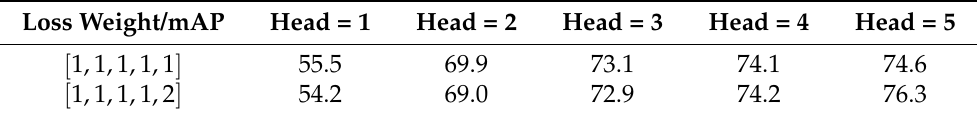
Table 9. Ablation experiments of the loss weight of different detection